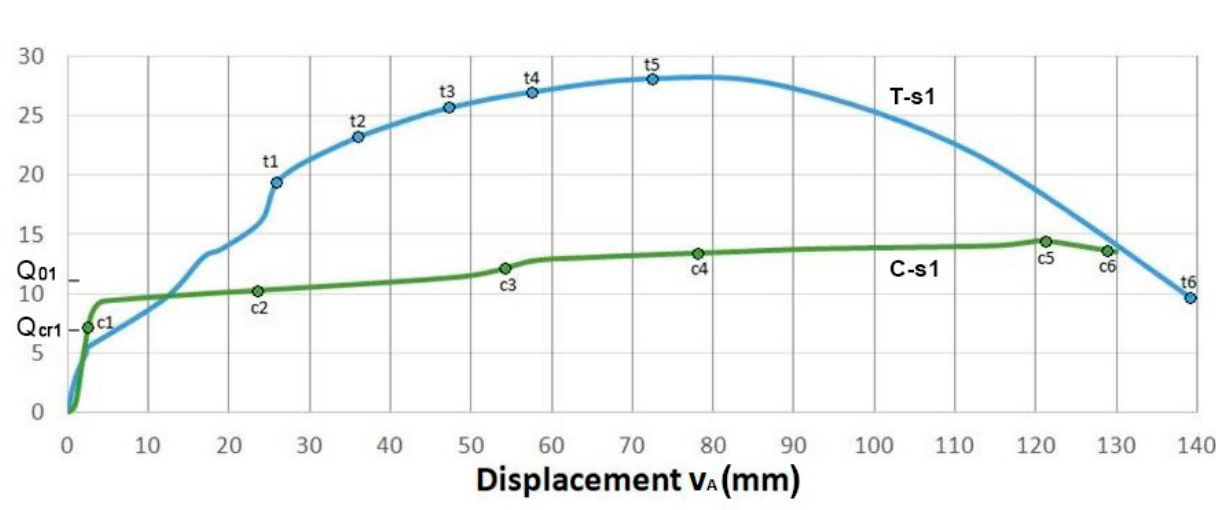
Figure 5. Displacement of the measuring point A in the midspan of beams Series 1 with the proposed truss reinforcement T-s1 and with conventional reinforcement C-s1 .